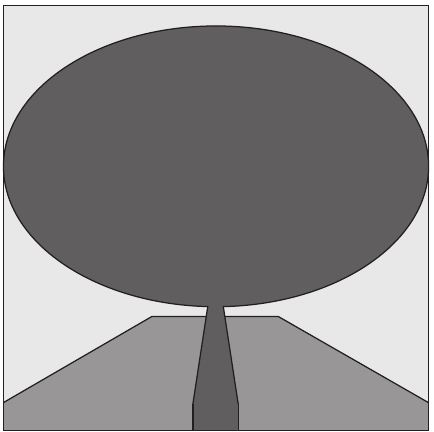
Figure 13: Configuration of the full-size UWB antenna [52]. Dark gray upper metal face, medium gray bottom metal face, and light gray dielectric